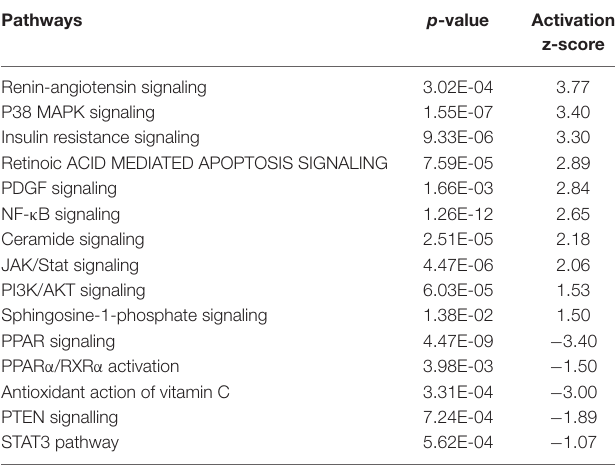
TABLE 1 | Top ingenuity canonical pathways altered by intrauterine inflammation in placenta. Pathways p -value Activation